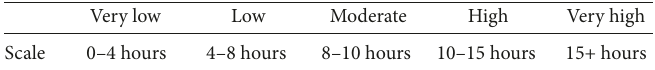
Figure 3: Example of a personal scale made by one of the participants for time spent running a